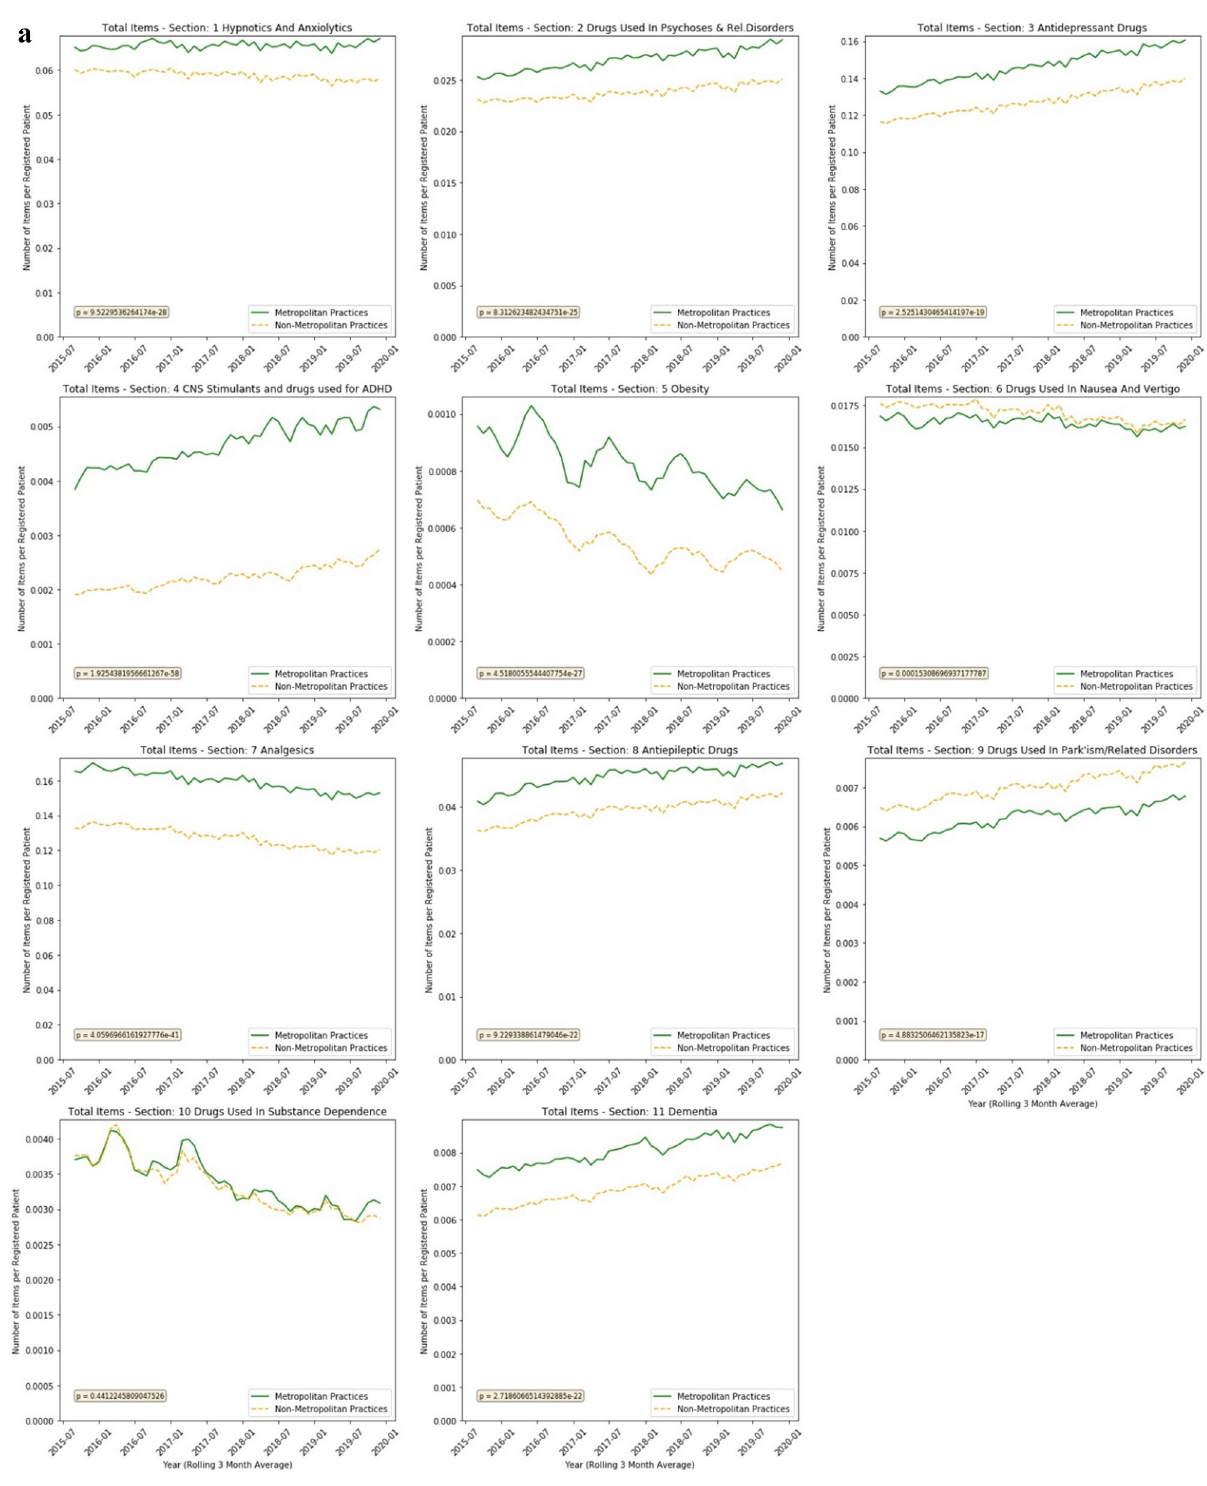
Figure 8. ( a ) Items per Patient for BNF Chapter 4 (Central Nervous System) Sections. ( b ) Comparison of RMSE by cluster at BNF section level (Chapter